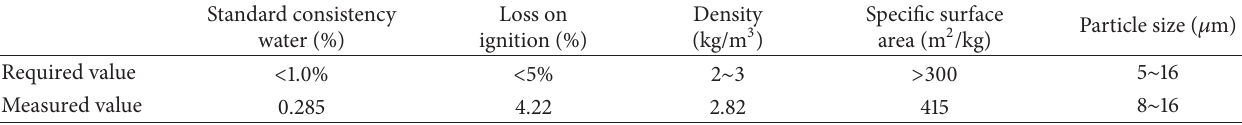
Table 3: Physical properties of CWCPM.